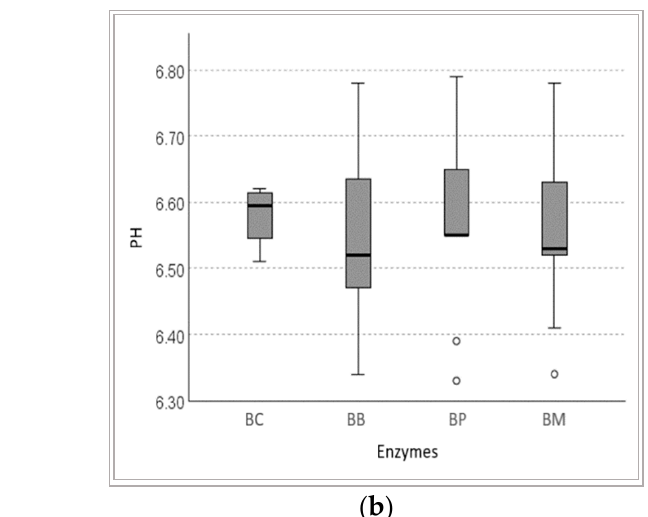
Figure 2. Changes in pH of all tested bran samples: ( a ) after 2 h; ( b ) and 4 h of hydrolysis with different enzymes (BC, control bran sample; BB, bran treated with bromelain; BP, bran treated with papain; BM, bran treated with a combination of bromelain and papain; the “°” marks indicate the median of pH for the bran control samples).